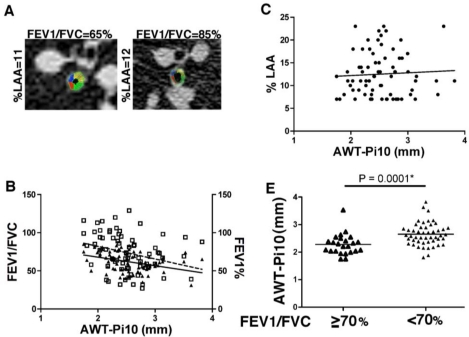
Airway wall thickness is increased in ever smokers with emphysema and airway obstruction. (A) A representative images of the internal perimeter of CT identified airway in subjects with similar degree of CT emphysema (11 and 12%) and with (left panel) or without (right panel) airflow obstruction. (B) Linear regression correlation of airway wall thickness (AWT-Pi10) was versus FEV1/FVC ratio (solid line; P = 0.0005; r = −0.3981) and FEV1% predicted (dashed line; P = 0.003; r = −0.3457) in 73 subjects with % emphysema between 7–23%. (C) AWT was plotted against % emphysema, with linear regression in the same group of 73 subjects. The correlation was not significant (P = 0.81, r = 0.0284). (D) Airway wall thickness (AWT-Pi10) measurements were assessed in 73 ever smokers with similar degree of emphysema (range 7 to 23%) comparing those with no airflow limitation (FEV1/FVC ≥ 70; N = 24) and with airflow obstruction (FEV1/FVC < 70; N = 49).